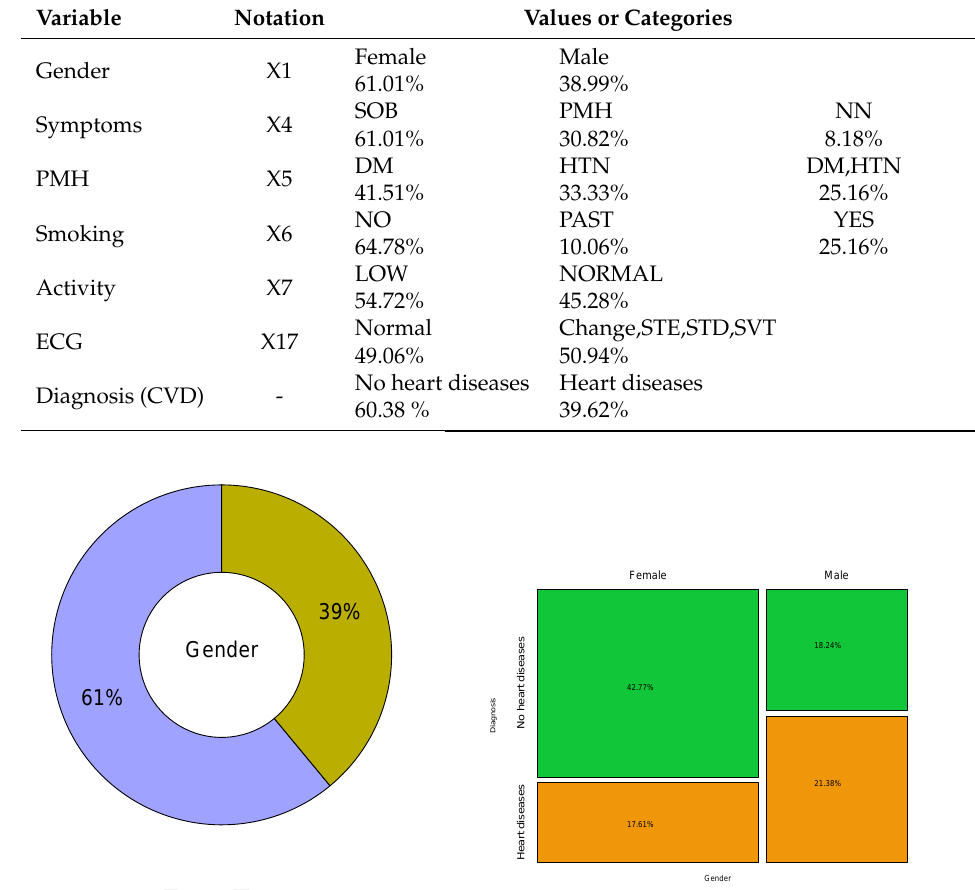
Table 4. Descriptive statistics of categorical variables under study; see abbreviations in Nomenclature.